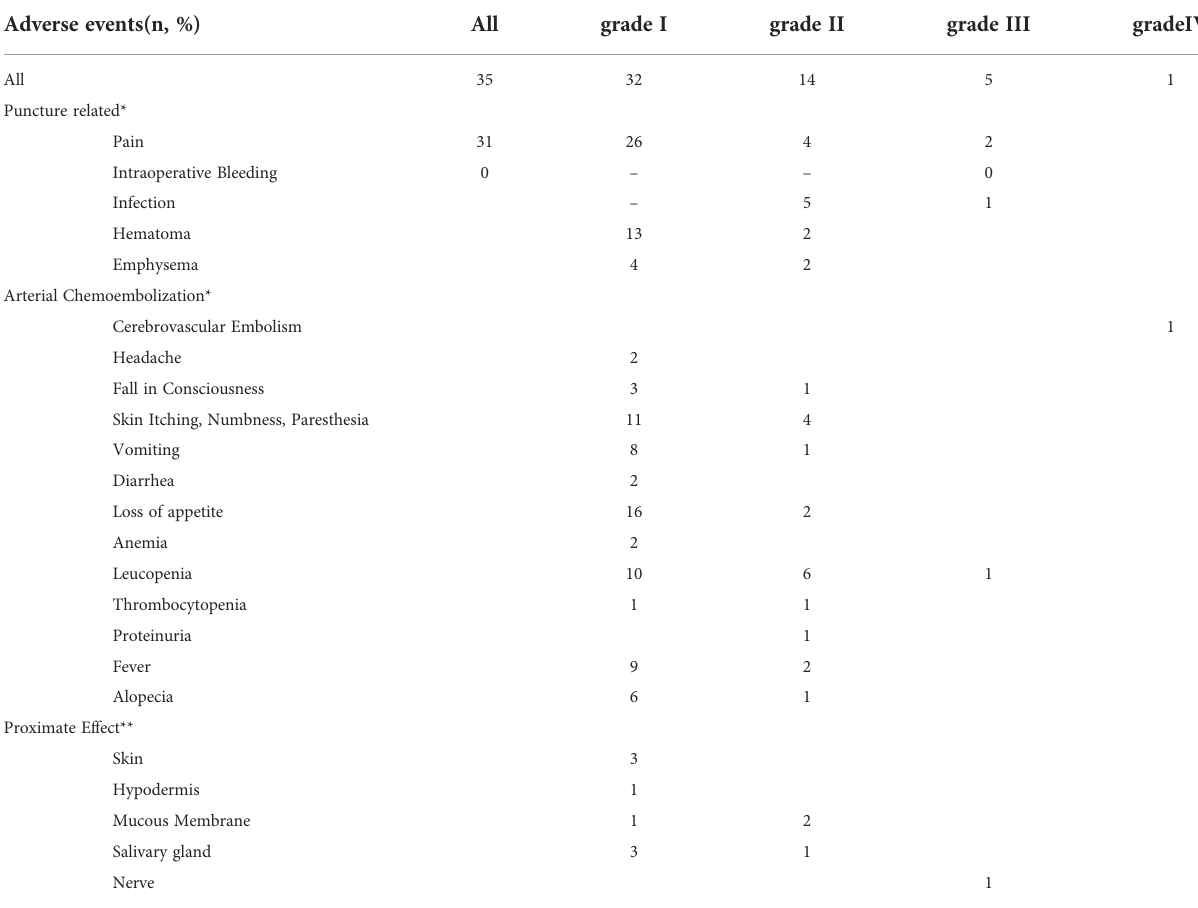
TABLE 3 Treatment-related adverse events. Adverse events(n,